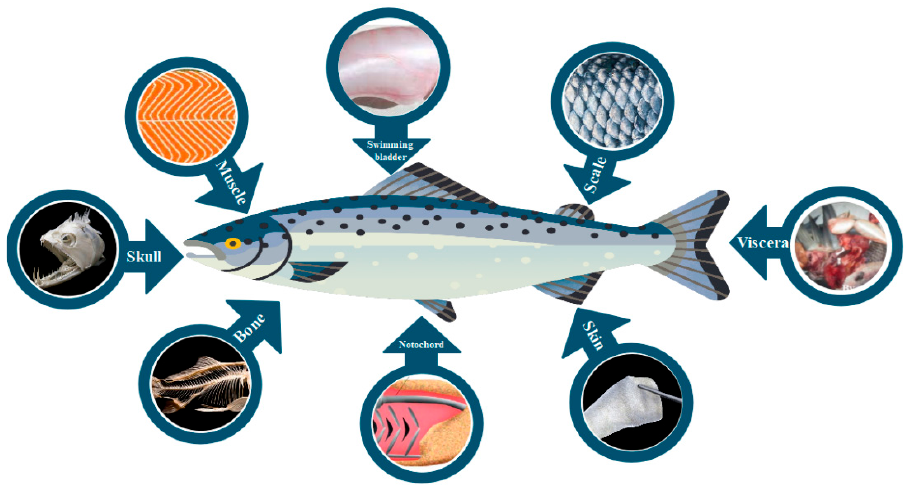
Figure 5. By-products of fish as potential sources of collagen extraction. Figure 5. By ‐ products of fish as potential sources of collagen extraction.